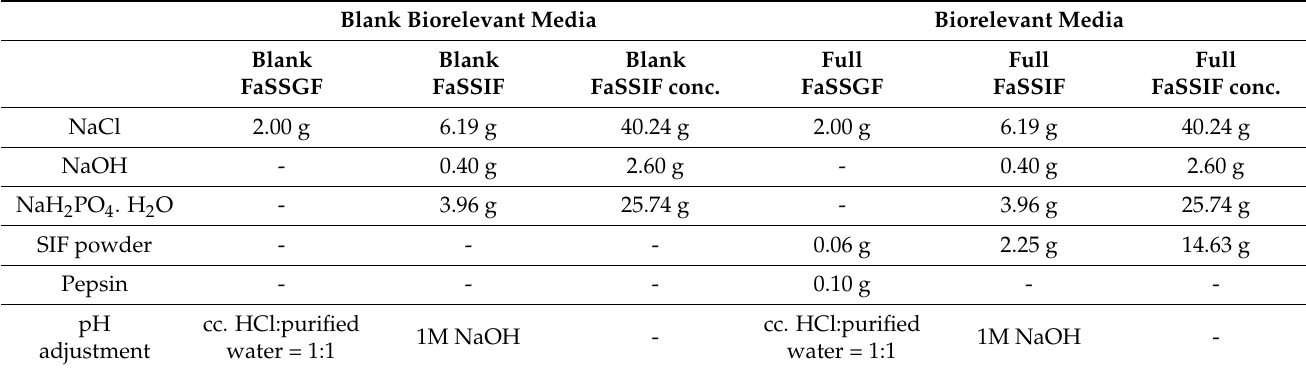
Table 2. Preparation of 1 L buffer solutions for GIS